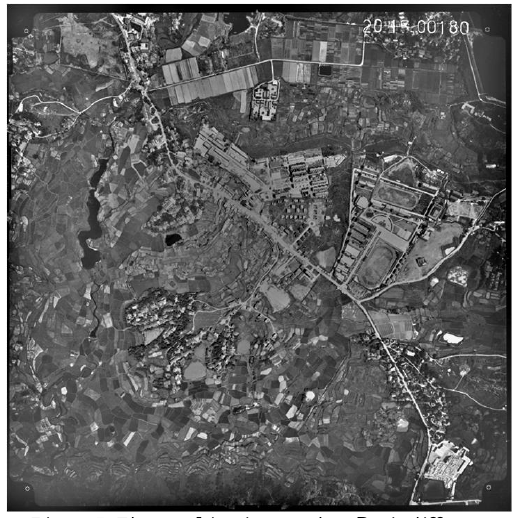
Figure 5. The resulting image when is different